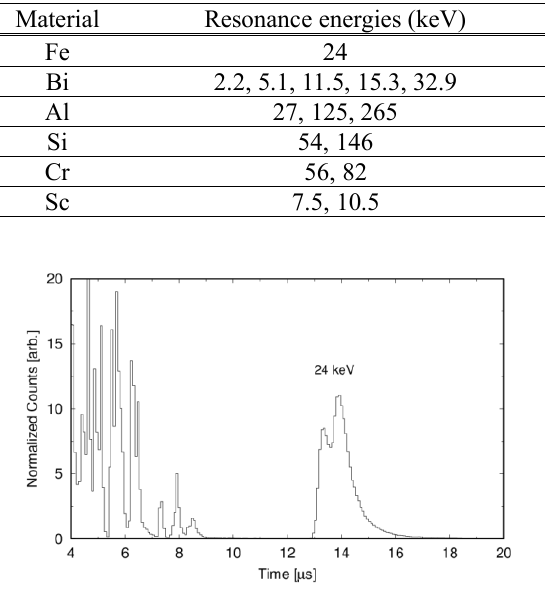
Fig. 3. Neutron TOF spectrum of neutron beam filtered with the 20-cm thick Fe filter.